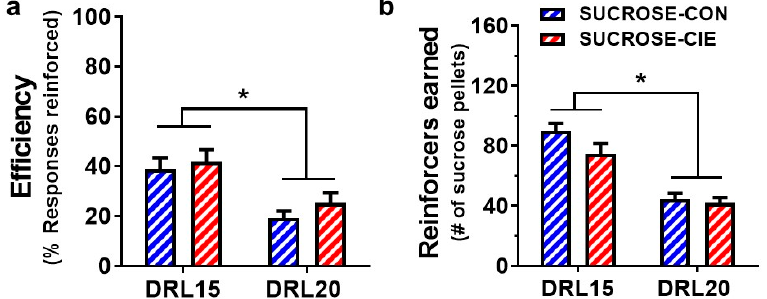
Figure 5. Efficiency of reinforcement and reinforcer intake were reduced during an unexpected DRL20 schedule compared with under the DRL15 schedule in sucrose animals. No differences were found between the SUCROSE-CIE group (red) and SUCROSE-CON group (blue) in ( a ) the efficiency of sucrose reinforcement or ( b ) the number of sucrose reinforcers that were earned. The data are expressed as mean ± SEM for percent reinforcers earned/responses emitted. n = 7–8/group. * p < 0.05, compared with corresponding values during DRL20